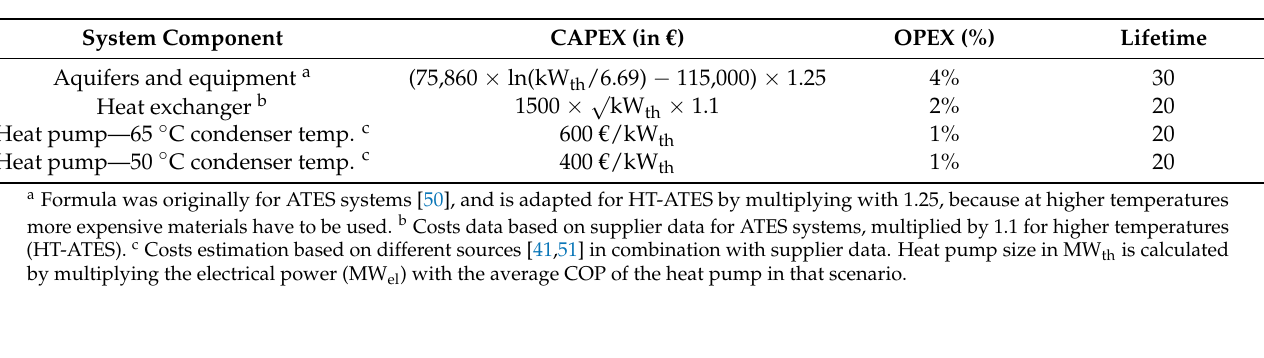
Table 4. Investment and operational costs for HT-ATES